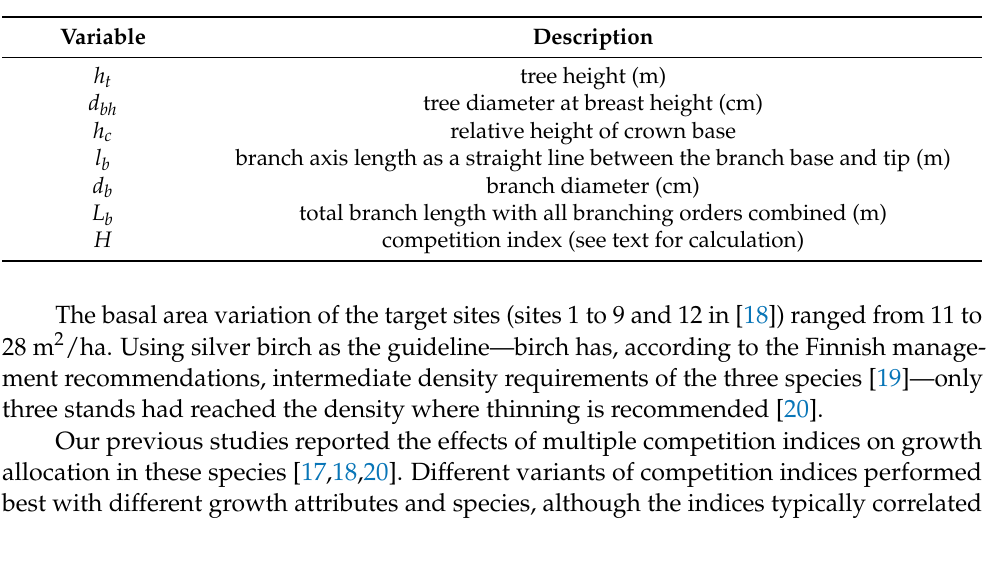
Table 1. Abbreviations and